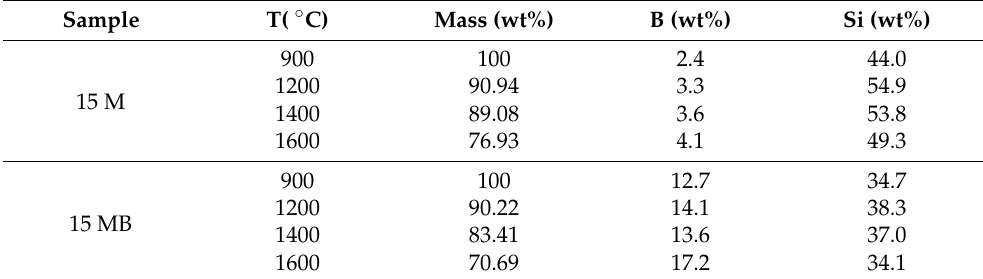
Table 1. High-temperature treatment of 15 M and 15 MB ceramic products.